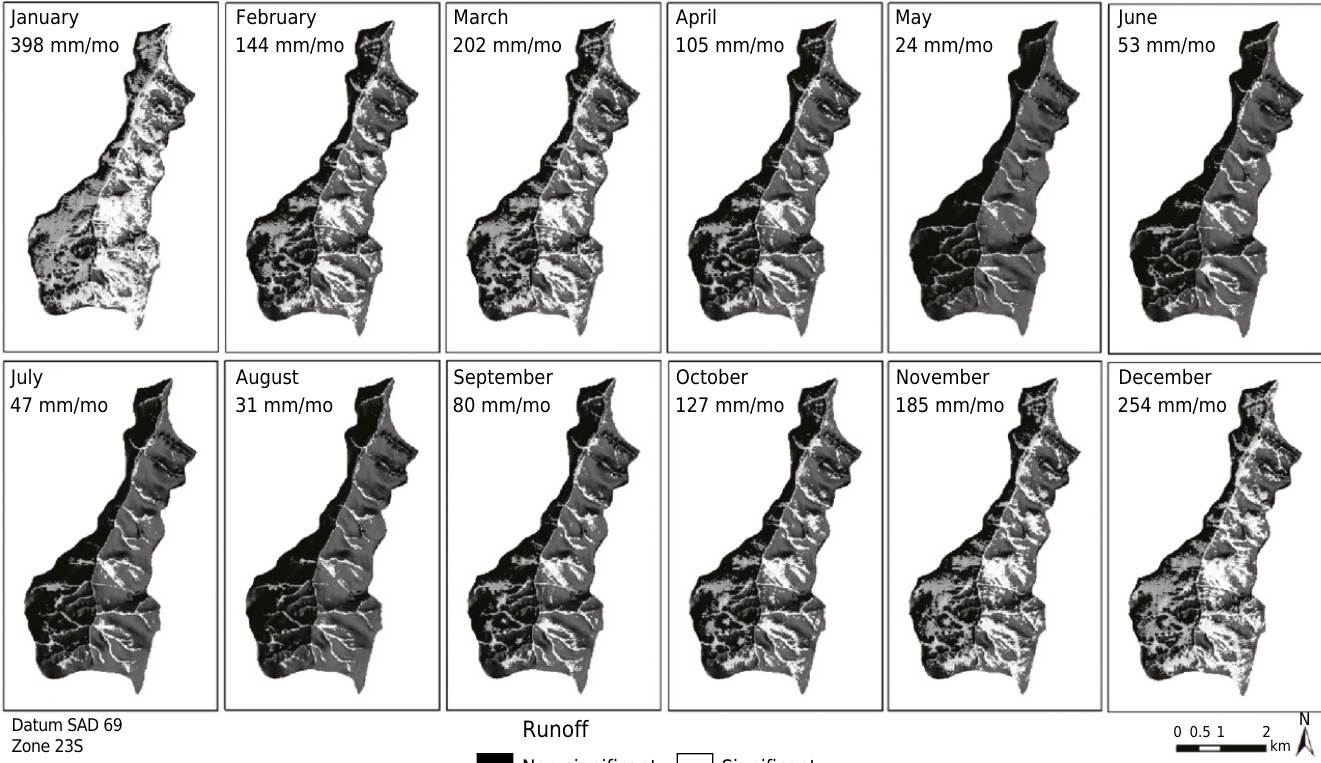
Figure 5. Soil vulnerability to runoff and average monthly rainfall in the Posses watershed,